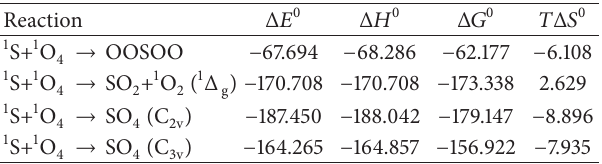
Table 6: The thermodynamic data of the S+O singlet PES at the B3LYP method (kcal/mol). Reaction Δ𝐸